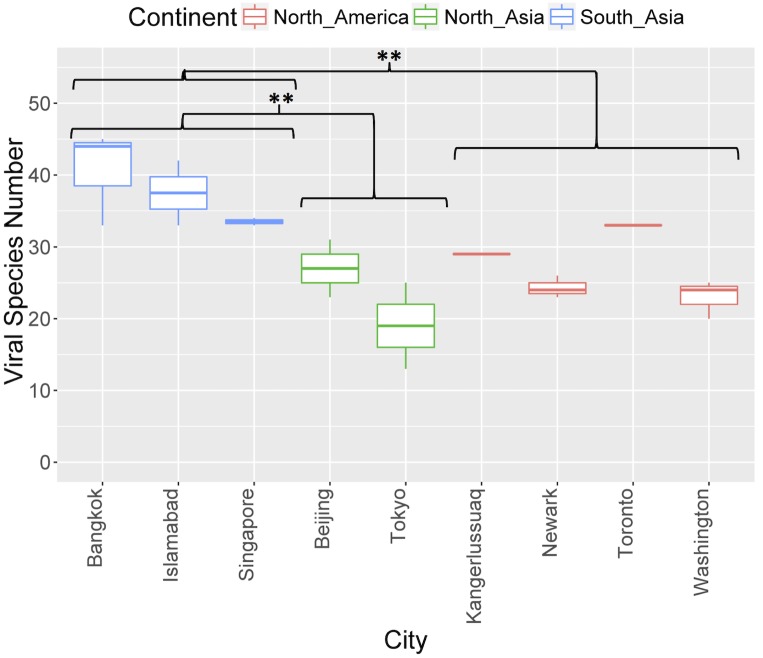
Viral species richness of the samples grouped according to their city of departure.Statistical analysis was done on region level, using Anova to test for significance (p<0.05) followed by pairwise t-tests with Bonferroni correction for multiple testing. ** = p<0.01.